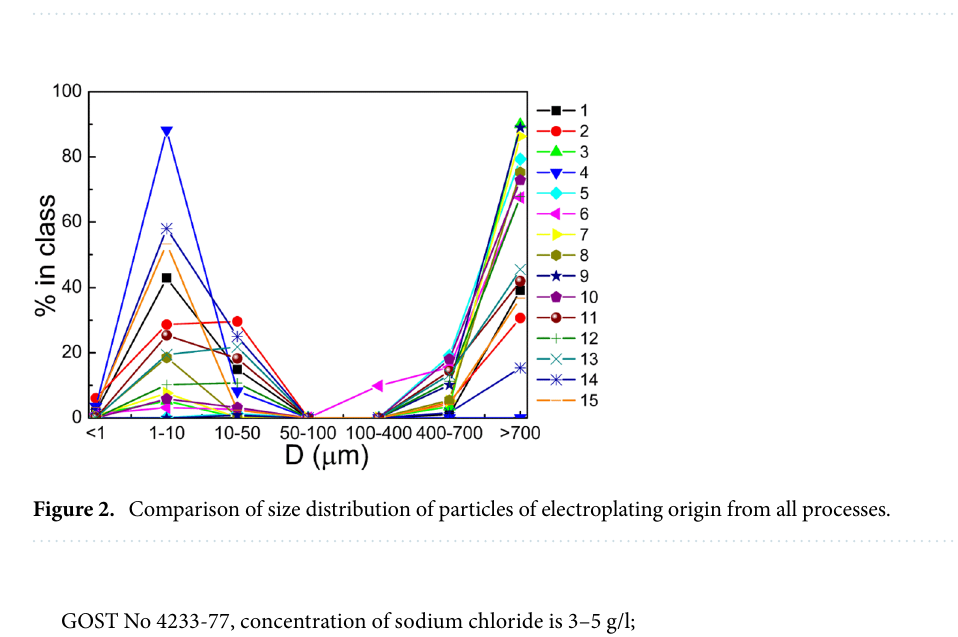
Table 3. Quantitative composition of industrial aerosol particles in the electroplating workshop. a Bold shows highest results.